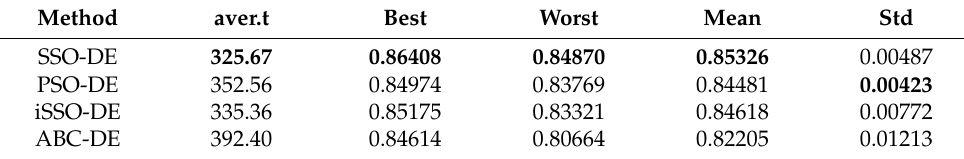
Table 23. Experiment results for winter.